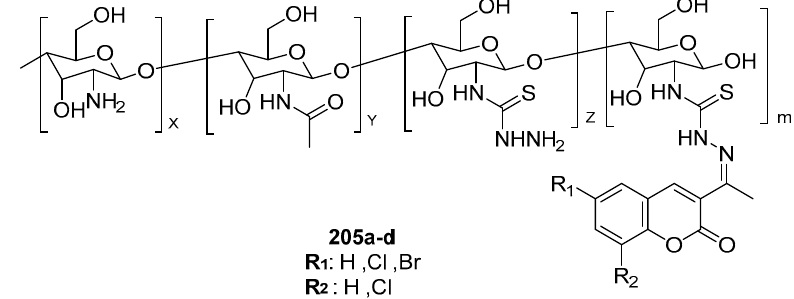
Figure 67. Chemical structure of coumarin-functionalized chitosan 205a–d .